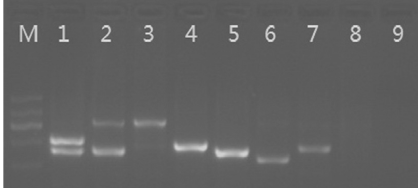
Figure 4: Identification results of commercial meat samples. Samples in lanes 1–7 were labeled as deer, mutton, mutton, beef, pork, camel, and yak meat. Lane 8 was soybean DNA, and lane 9 was negative control. But, the samples in lanes 1 and 2 contained